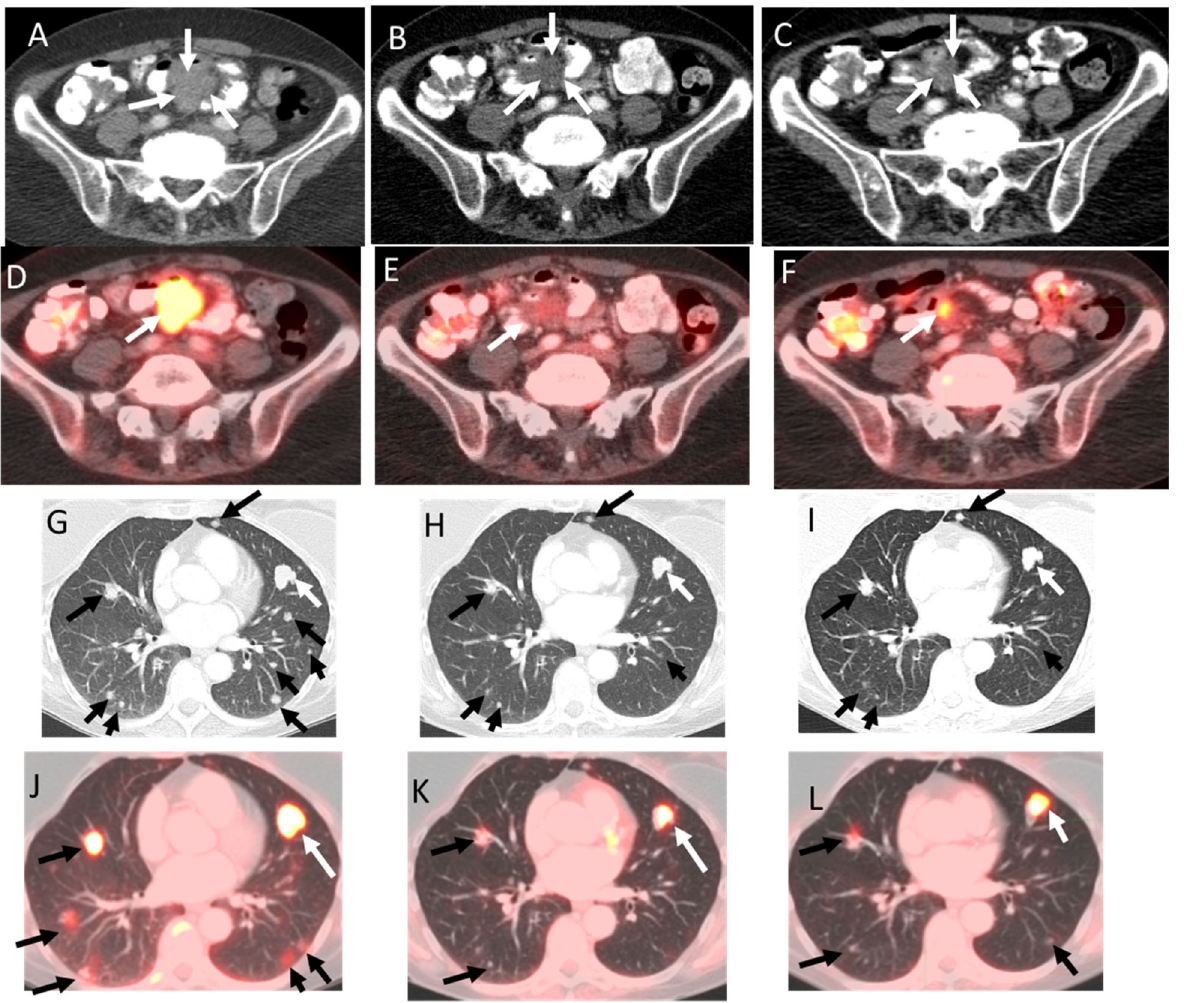
Fig. 2 Serial axial CT and fused PET/CT images from contrast enhanced PET/CT examinations at baseline, 4.5 months and 8.5 months illustrate disease response. Serial axial CT ( A – C ) and fused PET/CT ( D – F ) images of the abdomen in soft tissue window show response in the mesenteric implant with decreased size (white arrows in A – F ) and signi fi cantly decreased FDG uptake with a maximum SUV of 10.5 at baseline, 3.6 at 4.5 months follow up and 4.8 at 8.5 months follow up. Serial axial CT ( G-I ), and fused PET/CT ( J-L ) images in lung windows showed a response in the lung metastases. The largest metastasis in the lingua remained grossly stable in size (white arrows in G-I ) but showed decreased uptake with a maximum SUV of 20.1 at baseline, 8.8 at 4.5 months follow up and 8.6 at 8.5 months follow up. Multiple other smaller lung metastases (black arrows in G-L ) also showed decreased size and decreased